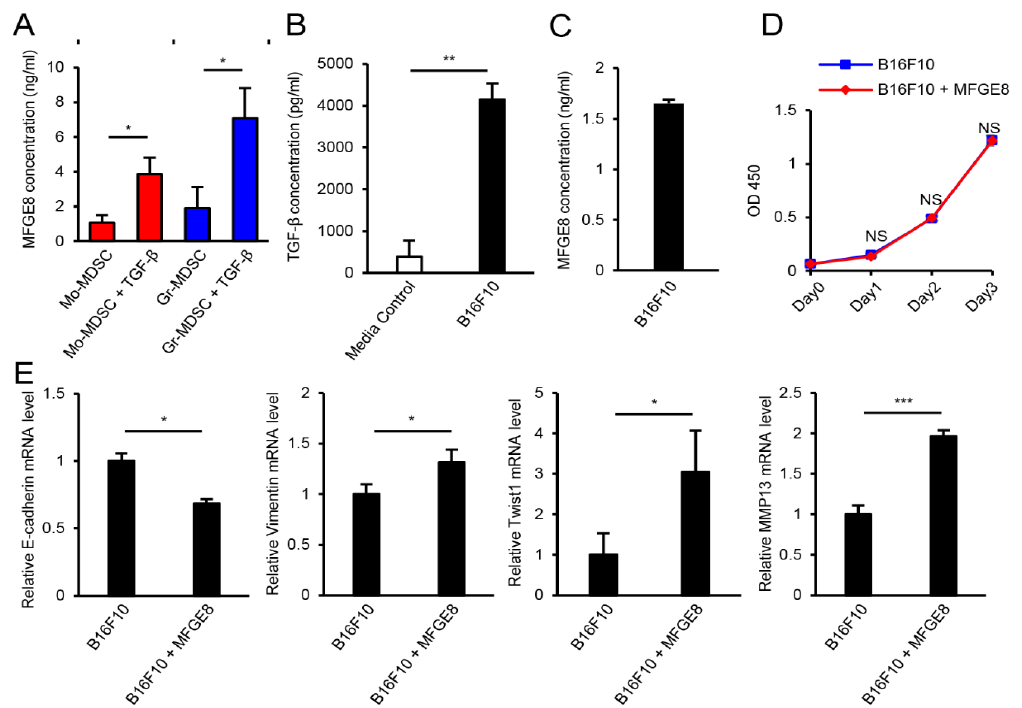
Figure 4. MFGE8 induces EMT of B16F10 melanoma. ( A ) ELISA of MFGE8 production by Mo-MDSCs and Gr-MDSCs in response to TGF- β treatment. ( B ) ELISA of TGF- β production by B16F10 melanoma cells. ( C ) ELISA of MFGE8 production by B16F10 melanoma cells. ( D ) WST assay of B16F10 melanoma cells in response to MFGE8 treatment. ( E ) mRNA levels of the EMT markers E-cadherin, vimentin, twist1, and MMP13 in B16F10 melanoma cells treated with MFGE8. Data are expressed as the mean ± SD. NS, not statistically significant ( p > 0.05). * p < 0.05, ** p < 0.01, and *** p < 0.001 by two-tailed t -test.